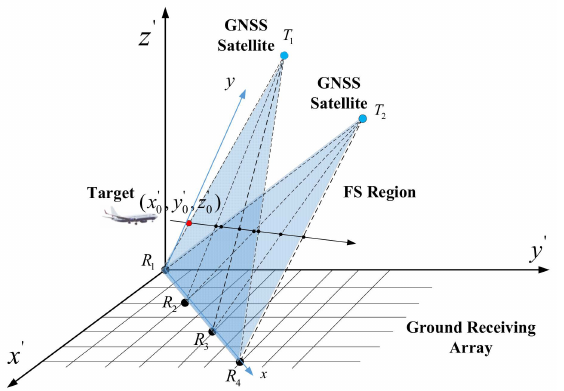
Figure 1. FSR network